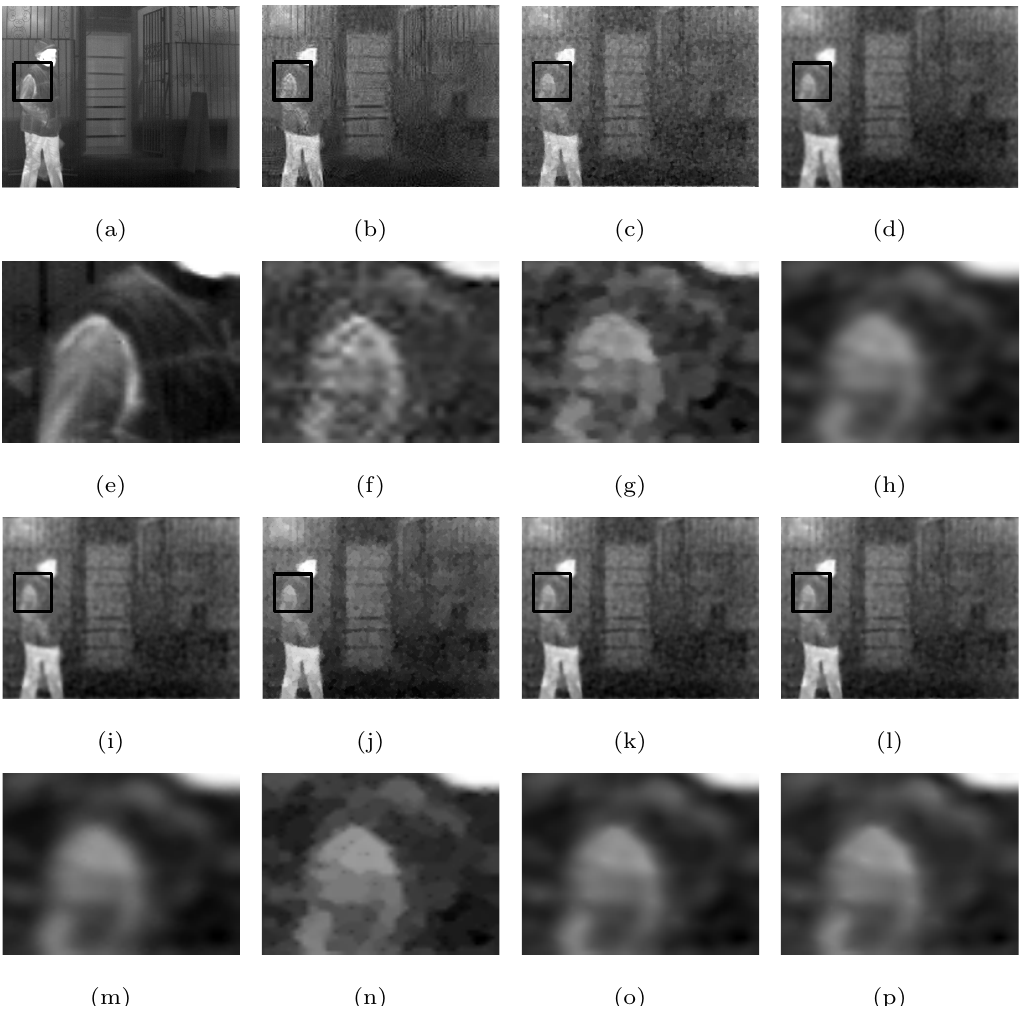
(p) 图 1: description of figure 图 1: description of figure 图 1: description of figure 图 1: description of figure Figure 10. Super-resolution x2 results of the LR passerby images with added white Gaussian noise 图 1: description of figure ( σ = 20); ( a – d , i – l ) ground truth and the results of the Bicubic, MFT, TV, TGV, TV4, FTV4 and FTV4Lp methods, respectively; ( e – h , m – p ) enlarged details from the rectangles in ( a – d , i – l ),